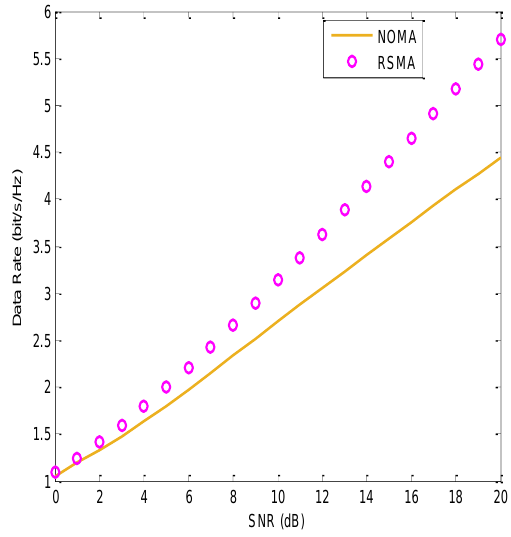
Figure 2. Spectral Efficiency comparison